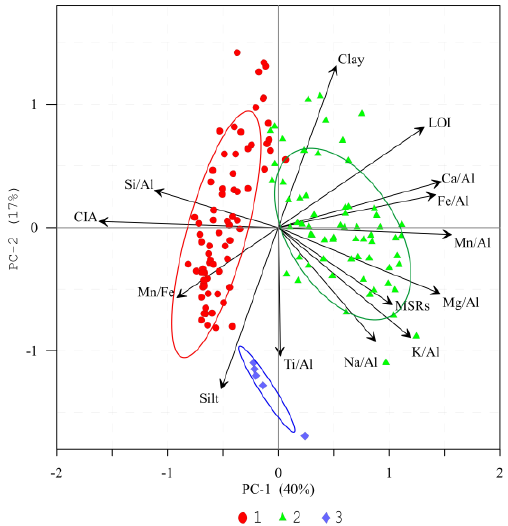
Figure 5. Summary of the principal component analysis of element ratios and distribution of selected indices along the studied core; 1—the group of ratios and indices related to silicate weathering and the supply of clastic material; 2—the group of ratios and indices associated with the supply of clastic material and weathering, leaching, and soil development; 3—the group related to the variations in the sediment grain size. Red circles —LGZ -1, green triangles—LGZ -3, and violet diamonds—LGZ -3.